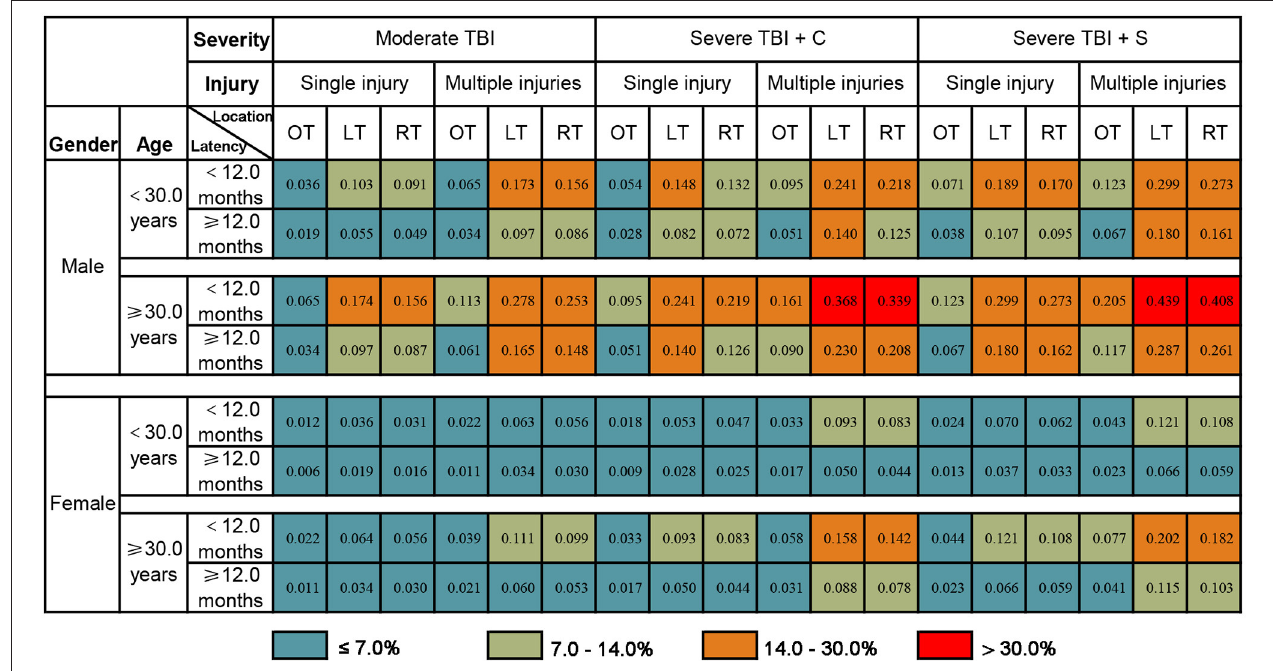
FIGURE 3 | The probability of an unfavorable 5-year global functional outcome of PTE patients. The number in each box represents the probability of an unfavorable 5-year global functional outcome. Determine individual risk in two steps: Step 1, Find the corresponding cell of a given individual according to the value of each predictor; Step 2, Determine the associated risk of unfavorable 5-year global functional outcome. For example, a male patient who suffered severe TBI (single injury on the left temporal lobe) at 30.0 years old, underwent conservative treatment, with a PTE latency of 6 months. The probability of an unfavorable 5-year global functional outcome for this given patient is 24.1%. TBI, traumatic brain injury; severe TBI + C, severe TBI with conservative treatment; severe TBI + C, severe TBI with surgery operation; OT, outside temporal lobe lesion; LT, left temporal lobe lesion; RT, right temporal lobe lesion.